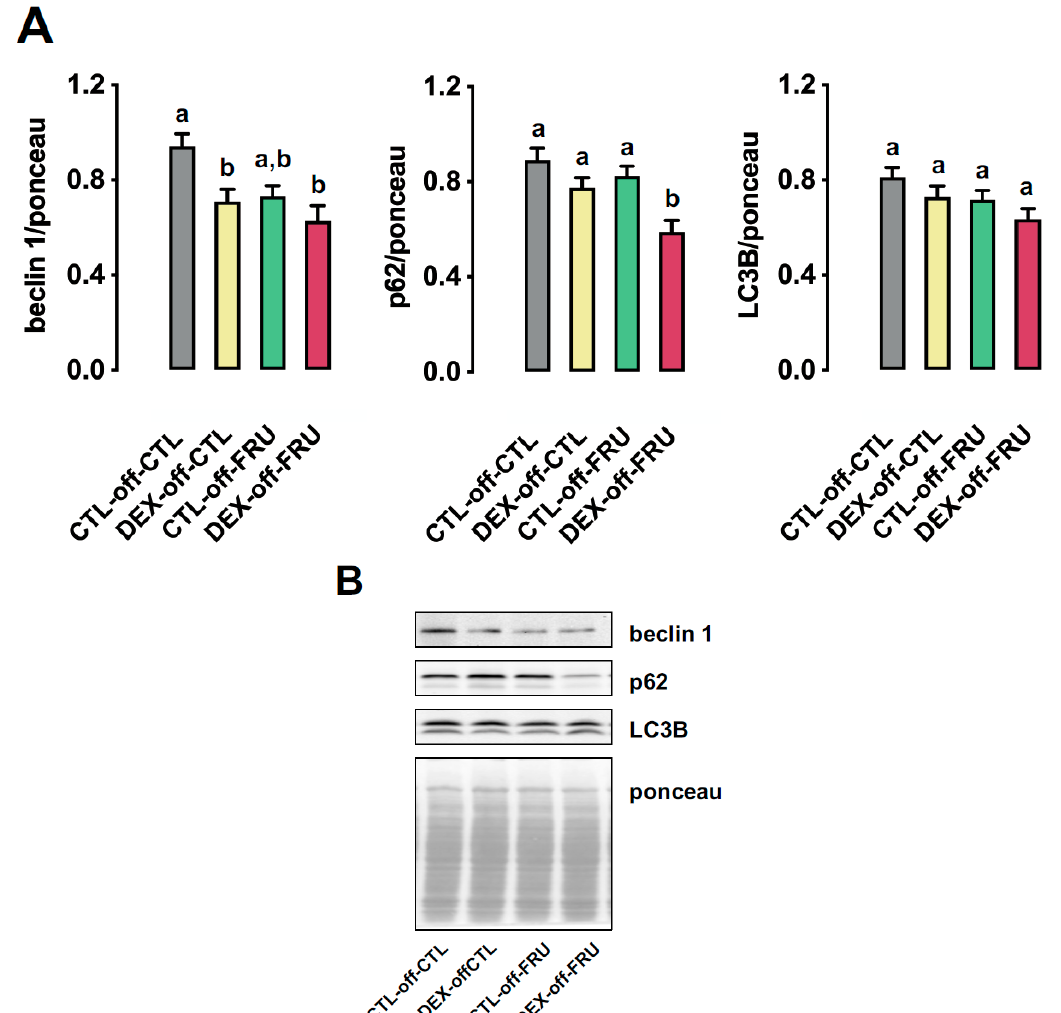
Figure 6. Effects of fructose on autophagy markers in rats exposed to DEX in utero. ( A ) Summary of beclin 1, p62, and LC3B expression in CTL-off-CTL, DEX-off-CTL, CTL-off-FRU, and DEX-off-FRU rats, as determined by Western blots. ( B ) Immunoblots were normalized using Ponceau-stained membranes. The results are presented as the mean ± SE. Means with different superscript minuscule letters are significantly different. The p values are provided in Section 3. N = 6 ‒ 8.